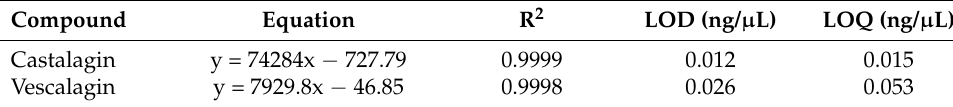
Table 1. Results of linear regression analysis of the LC-MS/MS. Compound Equation